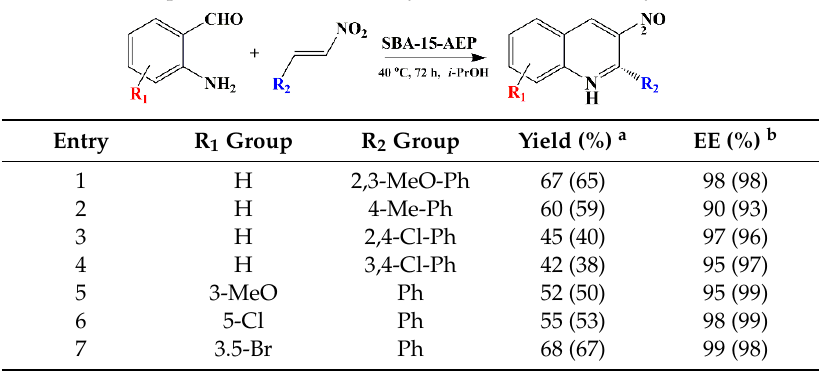
Table 3. Substrate scope for SBA-15-AEP catalyzed aza-Michael–Henry cascade